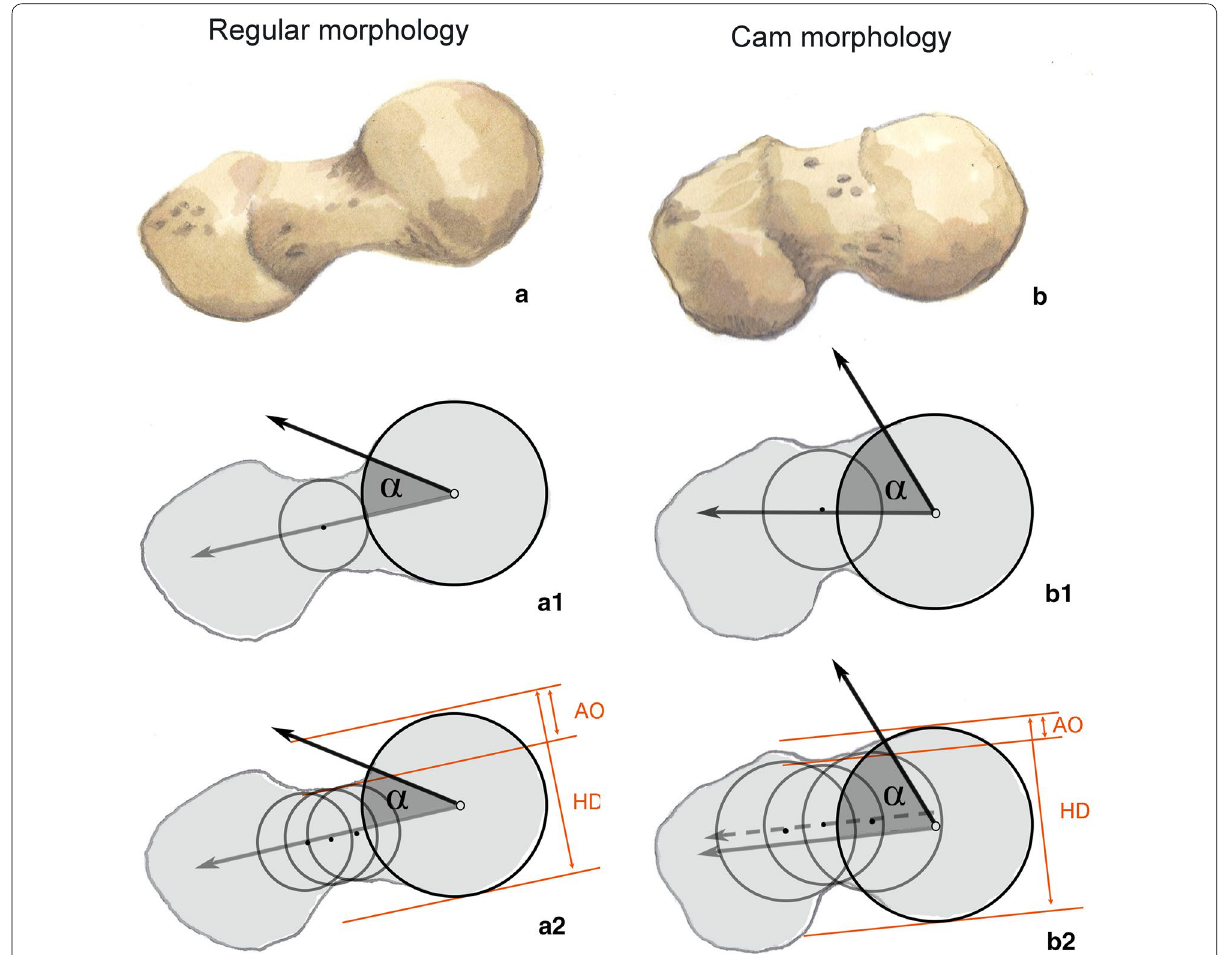
Fig. 2 α-Angle goniometry. The proximal femoral epiphysis may exhibit a regular morphology ( a ) or a cam morphology ( b ). Since in a the femoral head center is in line with the neck axis, the 3-point method ( a.1 ) is as suitable as the anatomic one ( a.2 ), and both obtain α HD 0.217. In b the center of rotation of the femoral head is slightly behind the neck axis, thus α = inappropriate), while the anatomic method provides the correct value of 65° ( b.2 ). The AOR calculated in b.2 along the pure mid-neck axis (i.e., disregarding the head position) is 0.108, and belongs to the 2.5% left tail of the normal distribution of AORs ( AOR anterior offset ratio, HD head diameter, AO anterior